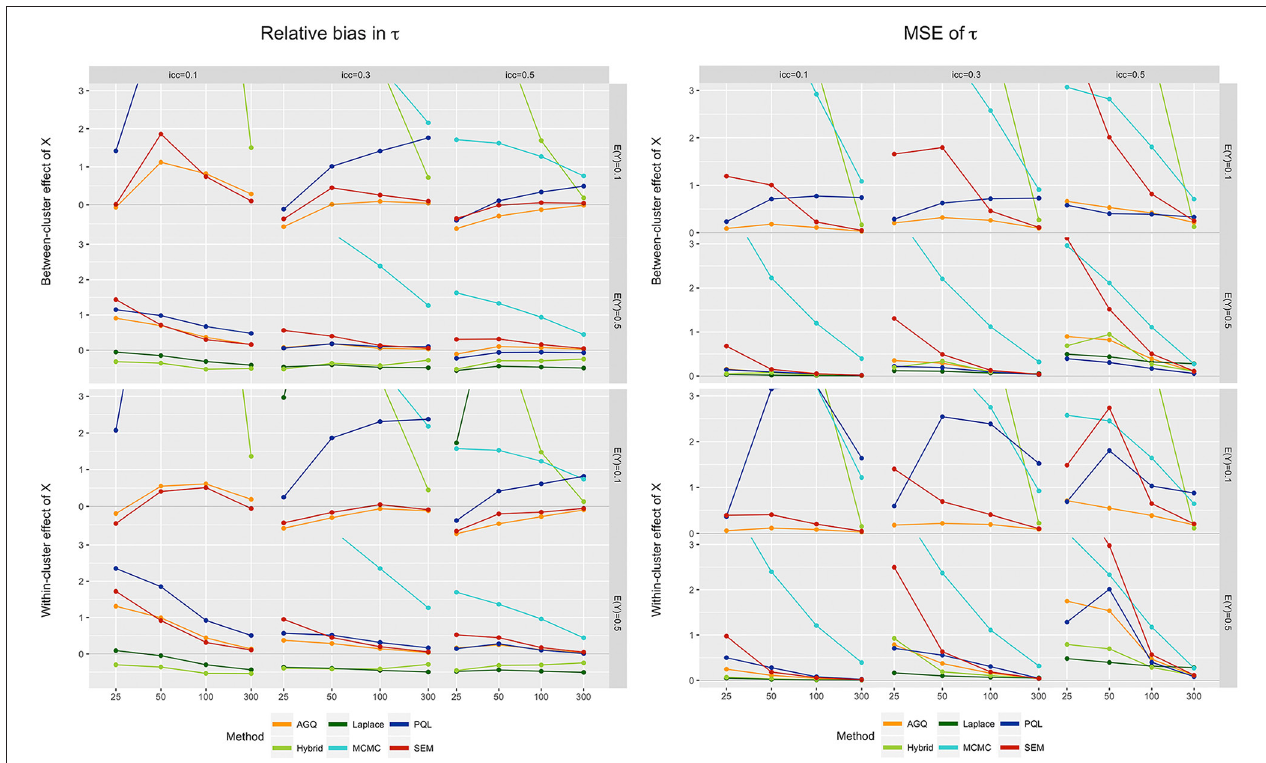
FIGURE 4 | Relative bias (left) and MSE (right) of τ for the six approaches, for different measurement levels of X (within- or between clusters), outcome prevalences (0.1 and 0.5), icc l (0.1, 0.3, and 0.5), and sample sizes (25, 50, 100, and 300). These results stem from simulation runs where all methods